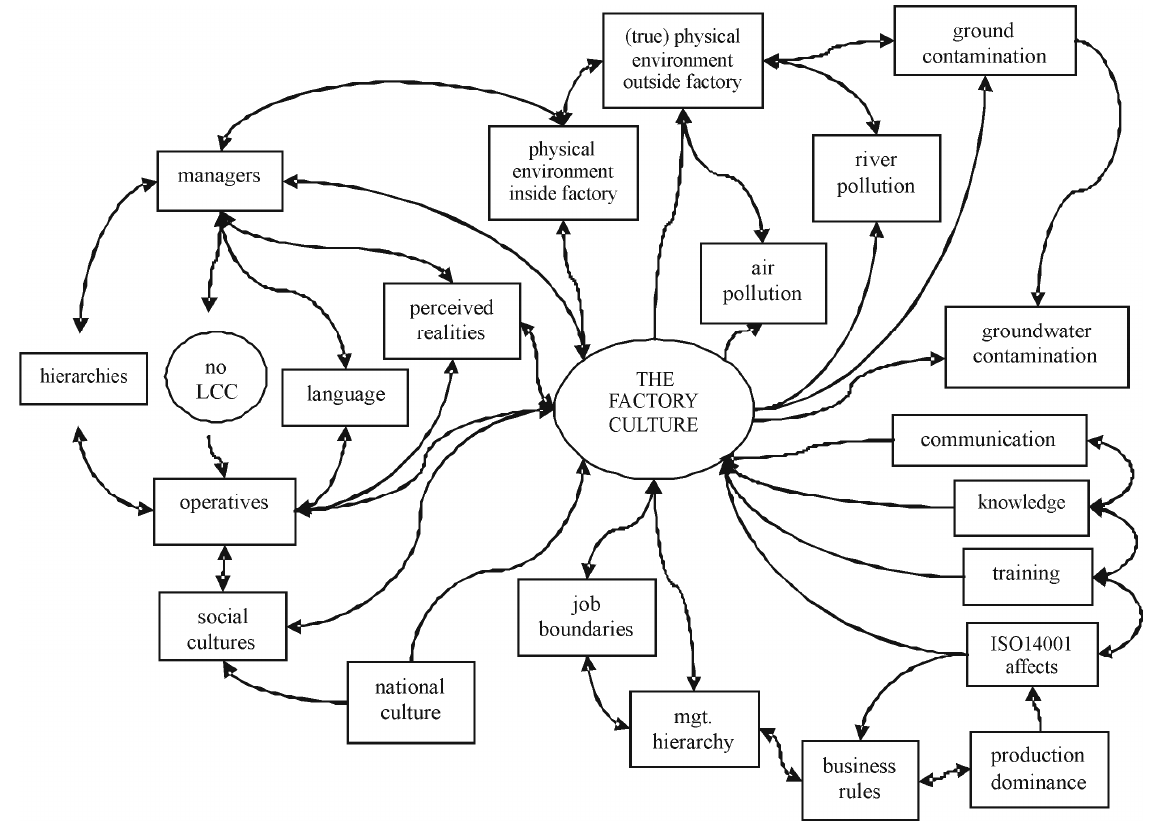
Fig. 1. Mapping of some of the interactive variables (taken from the research